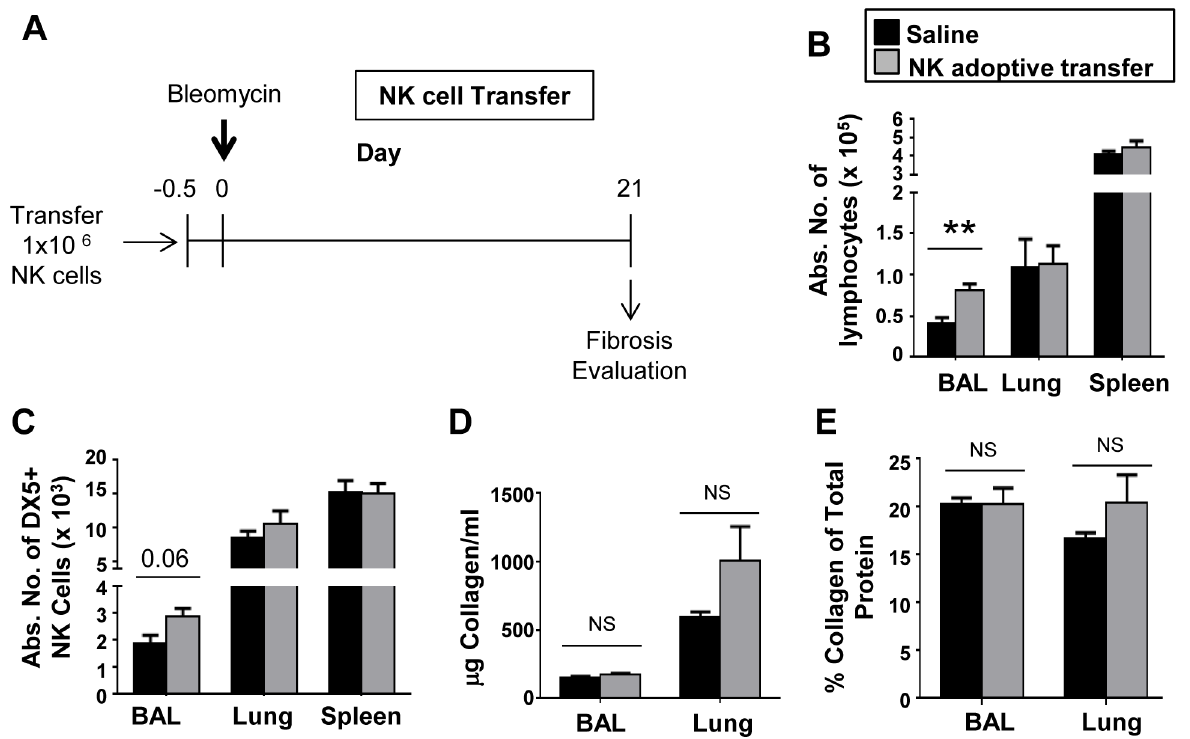
Figure 10. Adoptive transfer of NK cells does not alter pulmonary fibrosis in BIPF. ( A ) Recipient mice were injected with 1 million purified donor NK cells 12 h prior to bleomycin injection. ( B, C ) On day 21 leukocytes from BAL fluid, lungs, and spleen were collected, quantified, and stained with specific antibodies for leukocytes (CD45), NK cells (DX5), and T cells (TCR b ) and analyzed by flow cytometry. ( D, E ) Soluble collagen levels in BAL fluid and lung homogenates were measured by Sircol assay; total protein content was measured by BCA assay. Mean 6 SEM of n=5 mice per group; ** p , 0.01 by t -test.